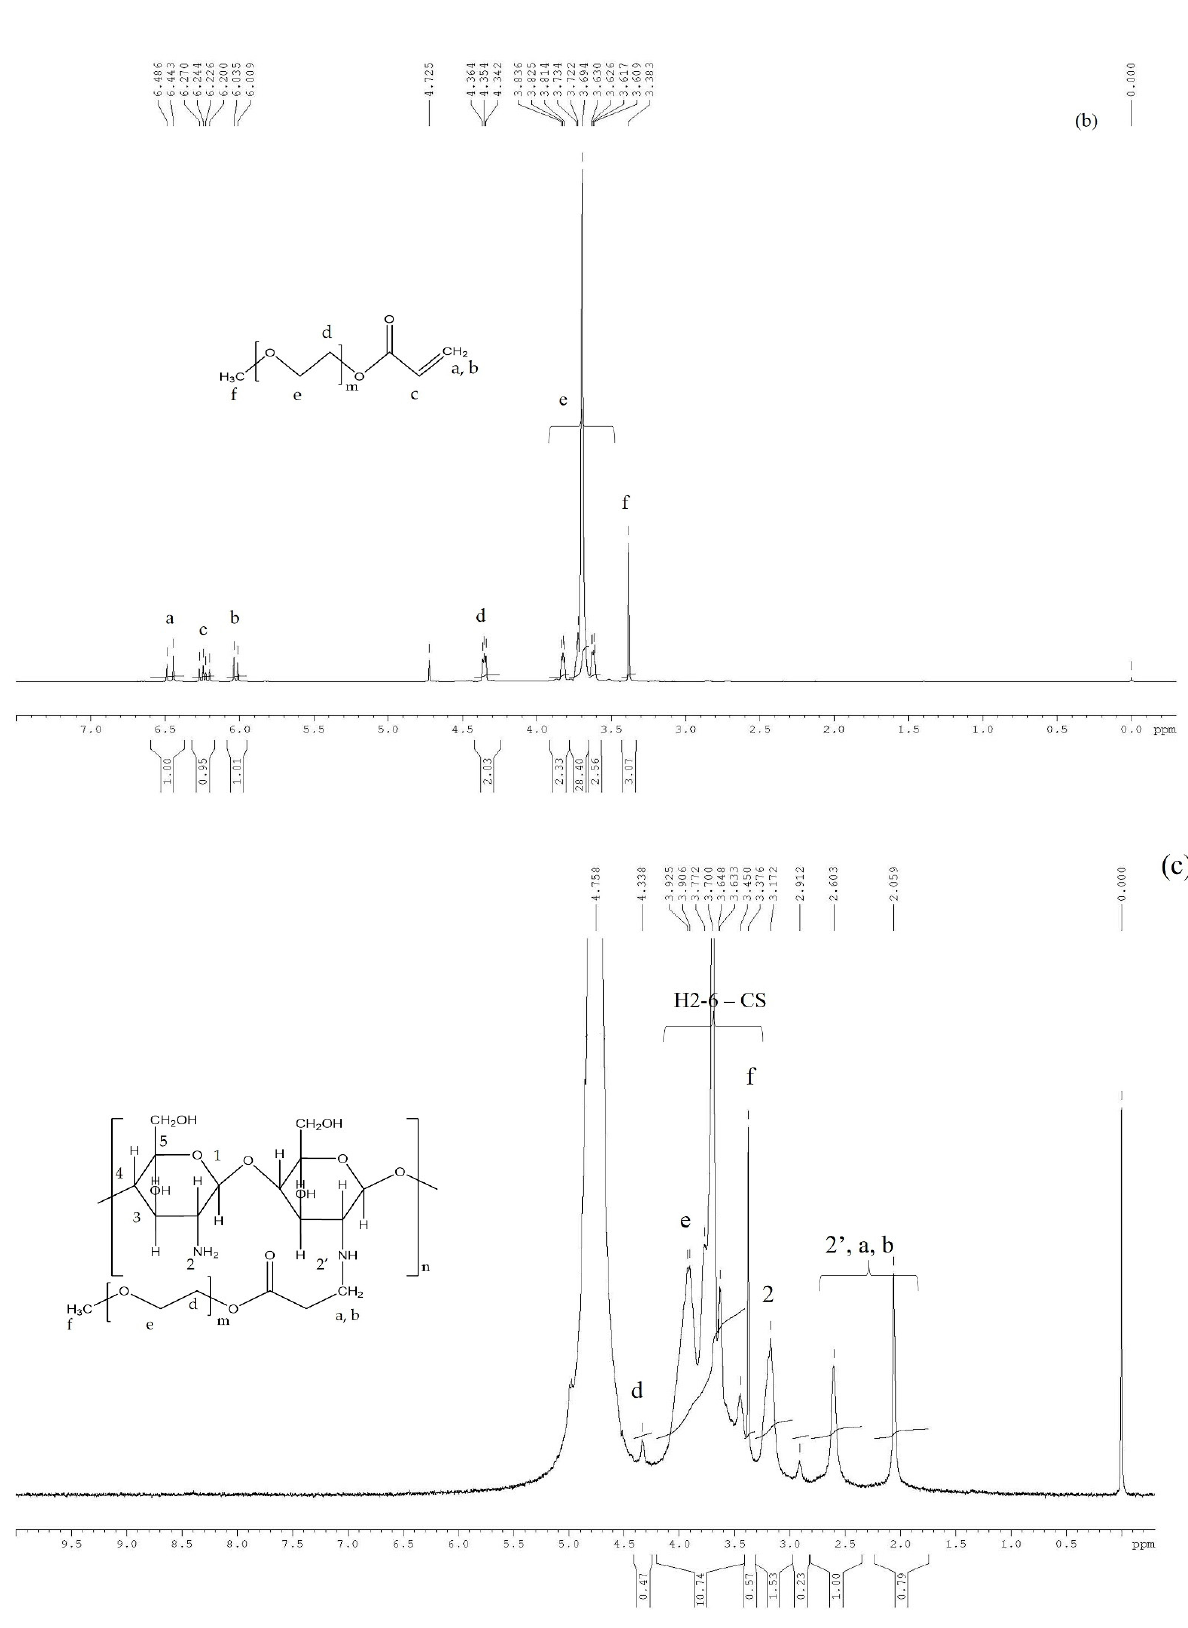
Figure 2. 1 H RMN spectra of ( a ) CS; ( b ) PEGA; ( c )